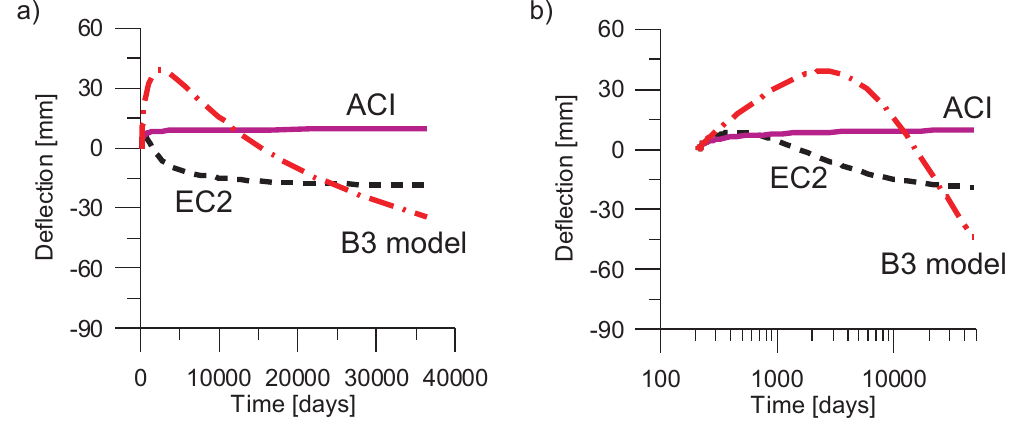
Figure 14. Bridge deflection (positive if upward) in normal ( a ) and logarithmic ( b ) scale computed with different creep